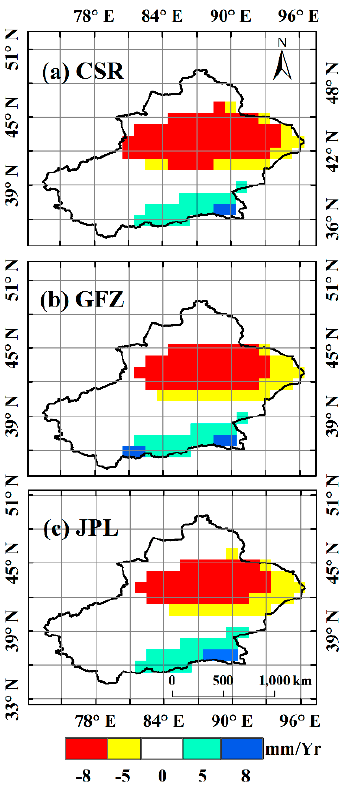
Figure 5. Mean annual GRACE (Gravity Recovery and Climate Experiment) water equivalent thickness in Xinjiang from 2003 to 2011. The histogram represents winter precipitation in mm. GRACE data from all three solutions were plotted: The Center for Space Research (CSR) at the University of Texas at Austin solution, the German Research Center for Geosciences (GFZ) at Helmholz Centre Potsdam